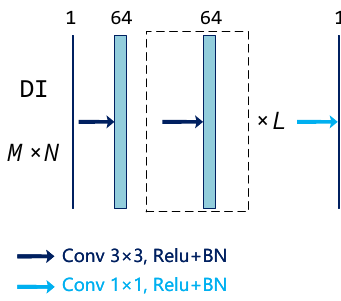
Figure 5. The CNN structure of the proposed change detection method. A cyan rectangle in the figure represents the side view of a tensor and the number above the rectangle represents the number of channels. FCNN contains L + 2 convolution layers. The number of 3 × 3 convolutional layer equals L + 1 and the number of 1 × 1 convolutional layer equals one. In this work, we set L =